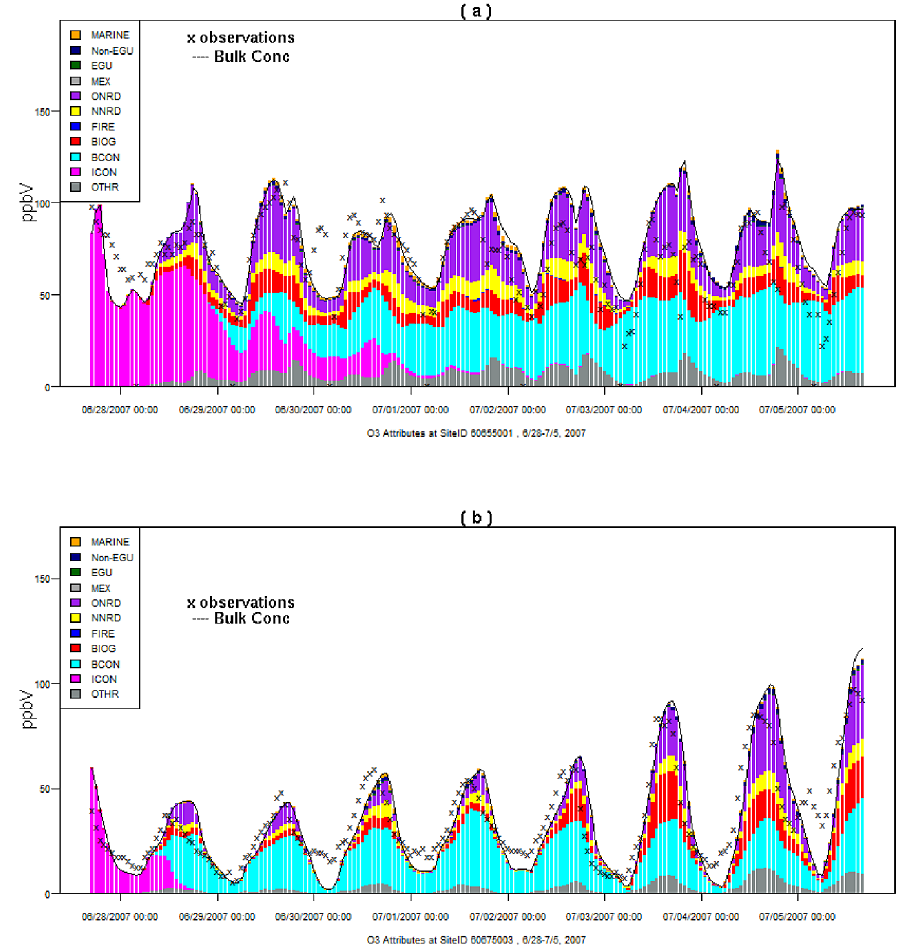
Figure 1. Hourly time series of O 3 observations (crosses) at sites of the California Air Resources Board monitoring network; and the cor- responding CMAQ-ISAM sector breakdowns (stacking colored bars). Locations are (a) Riverside and (b) Sacramento. The colors represent sector sources: marine (MARINE, orange), non-electricity generation units (Non-EGU, deep blue), electricity generation units (EGU, green), other point sources (MEX, light grey), on-road mobile (ONRD, purple), non-road mobile (NNRD, yellow), wildfires (FIRE, blue), biogenic (BIOG, red), boundary conditions (BCON, cyan), initial conditions (ICON, magenta), and remaining unspecified emissions (OTHR, grey). The solid black trace on top of the bars denotes the modeled bulk O 3